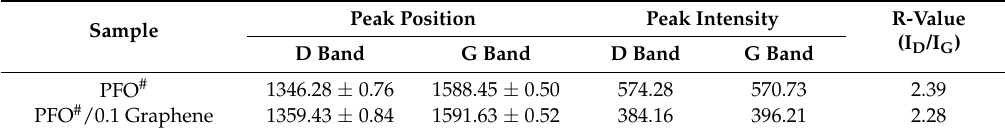
Table 4. Raman Spectra Results of PFO# and PFO#/0.1 Graphene-Based Carbon Fiber.